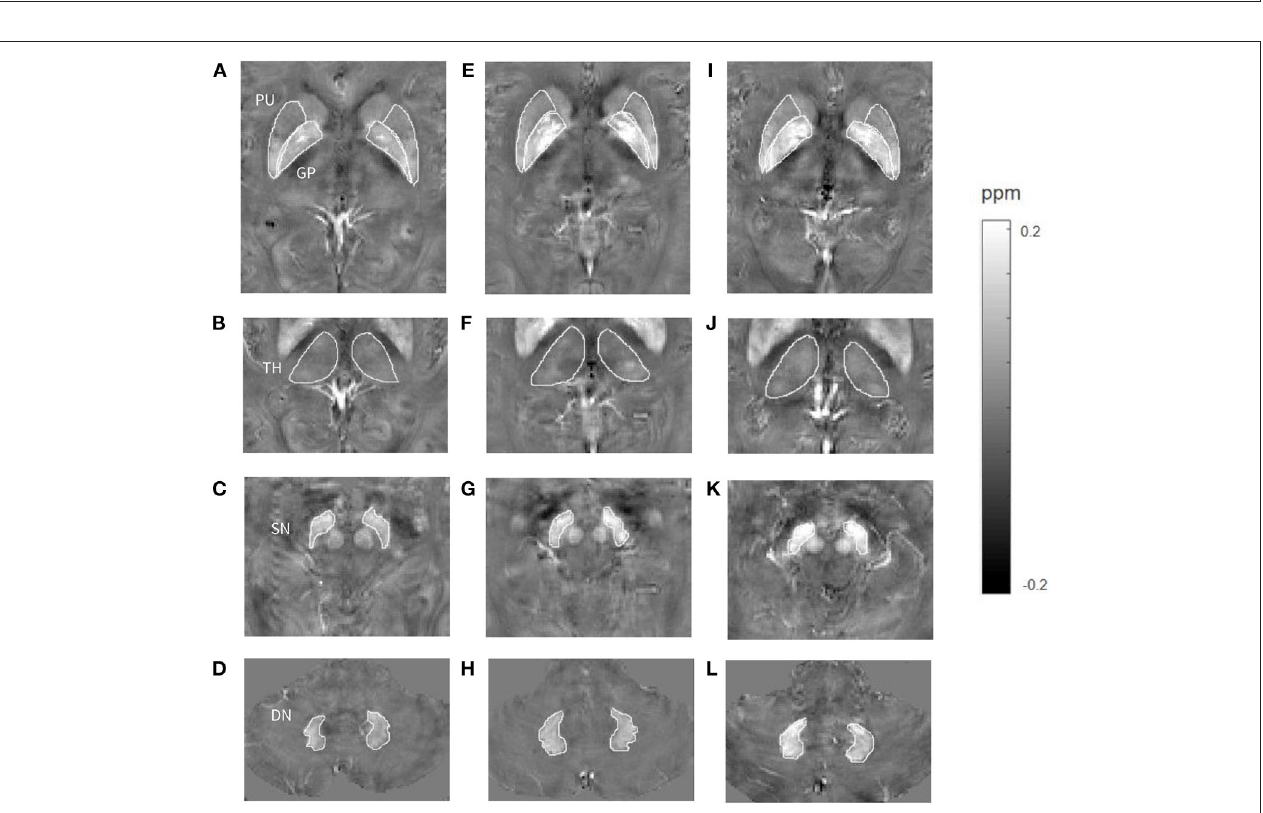
FIGURE 4 | Comparisons of susceptibility in gray matter nuclei among a healthy control ( A–D , a 65-year-old male), a patient with long-term anterior circulation artery stenosis (ACAS) ( E–H , a 62-year-old male) and a patient with long-term posterior circulation artery stenosis (PCAS) ( I–L , a 65-year-old male). Higher mean susceptibility of bilateral putamen (PU), globus pallidus (GP), and substantia nigra (SN) was shown in the ACAS patient, and of bilateral PU, GP, thalamus (TH), SN, and dentate nucleus (DN) was shown in the PCAS